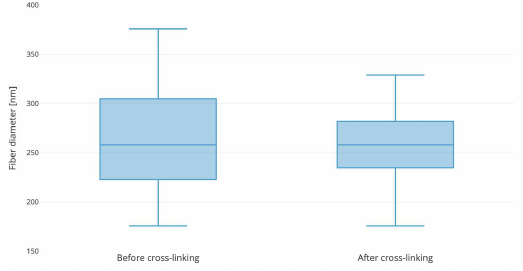
Figure 8. A box plot comparing the fiber diameter before and after the crosslinking. Fiber diameters are not statistically significant